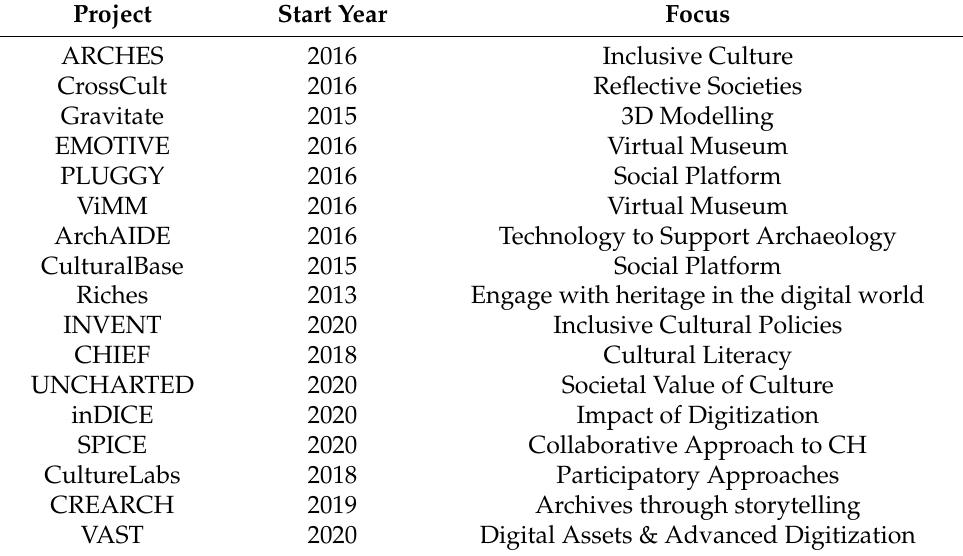
Table 1. List of projects related to